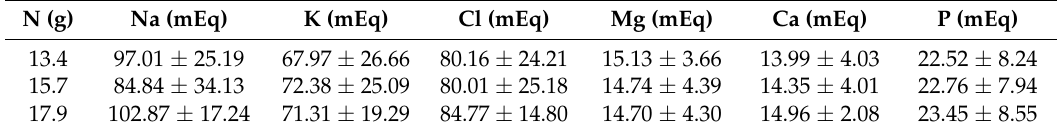
Table 3. Micronutrient profile in relation to nitrogen content (mean ± SD).